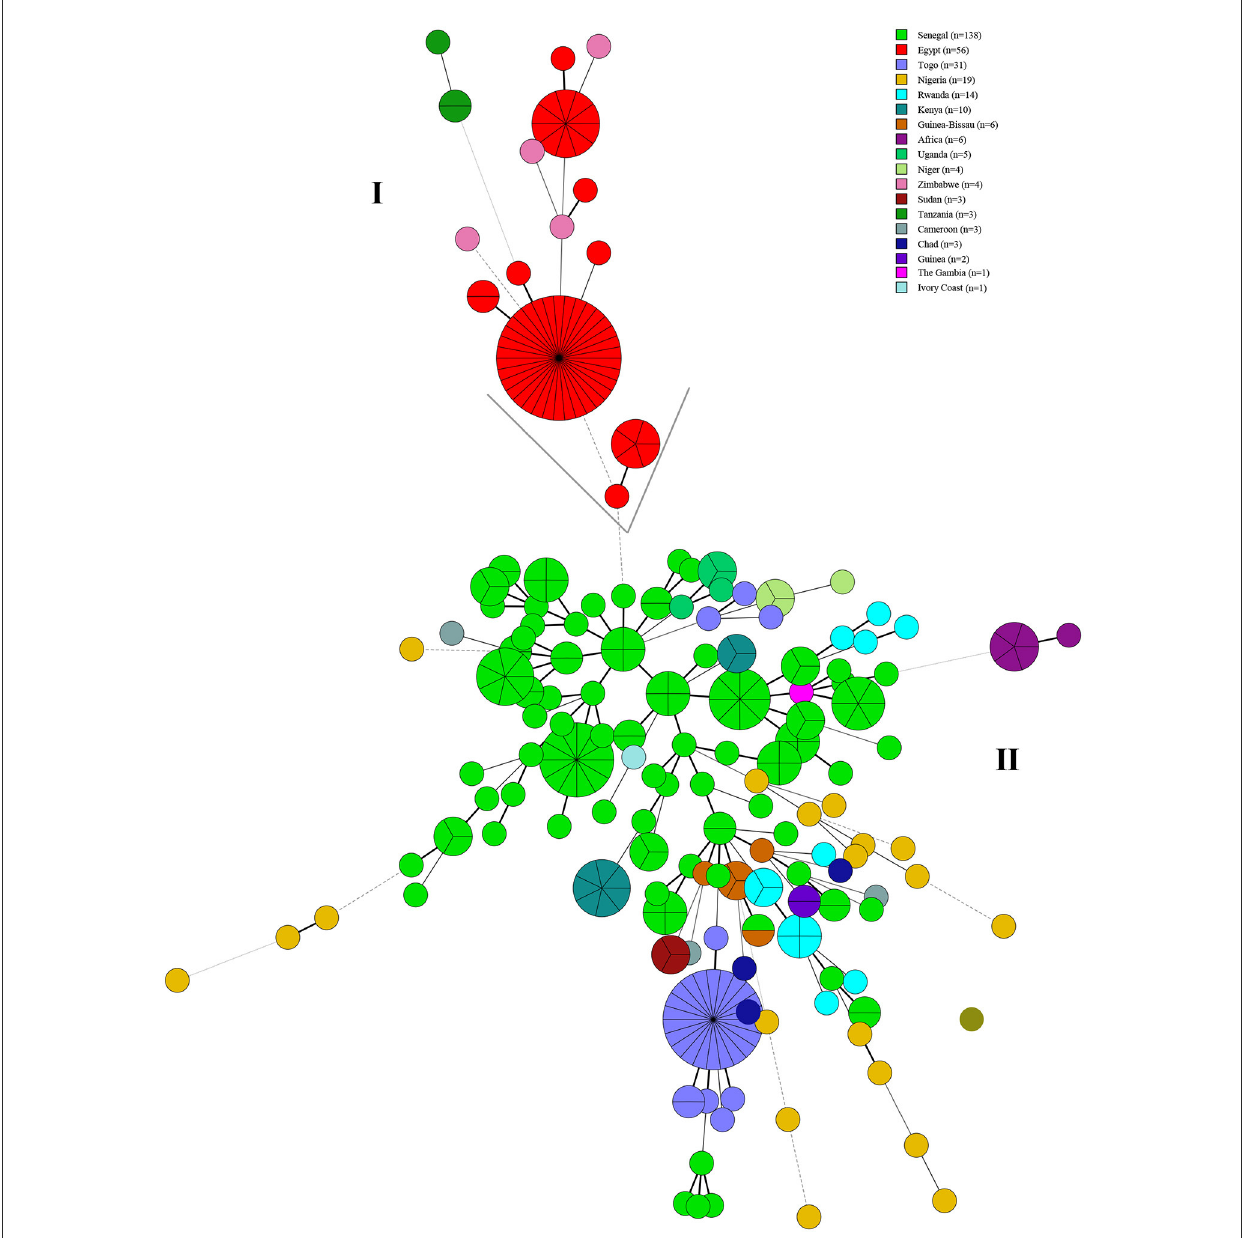
FIGURE5 Molecular epidemiology relatedness of B. abortus strains from West Africa based on the MLVA-16 data of 309 B. abortus . Color coding according to the country in this study. Circle size indicates the number of strains. Branch (I) comprised strains from Egypt, Zimbabwe, and Uganda and branch (II) contained strains from the other 14